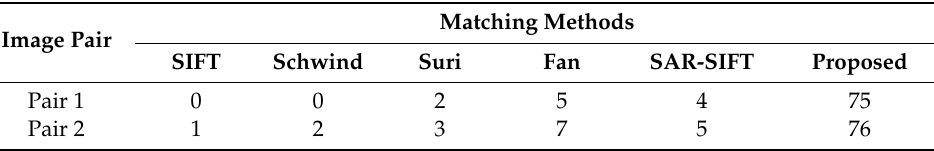
Table 8. NCM values of each method for SAR and SAR